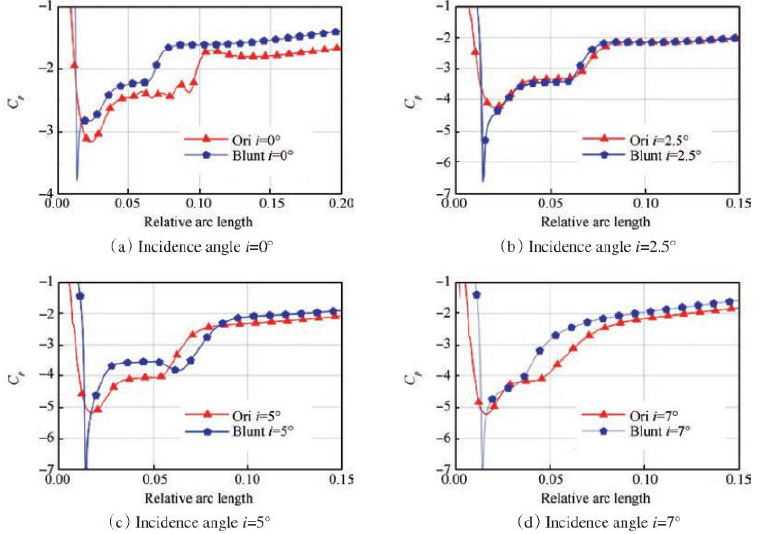
Figure 12. Pressure coefficient distribution on the suction side with an incidence angle ranging from 0° to 7°. Reproduced from [63].